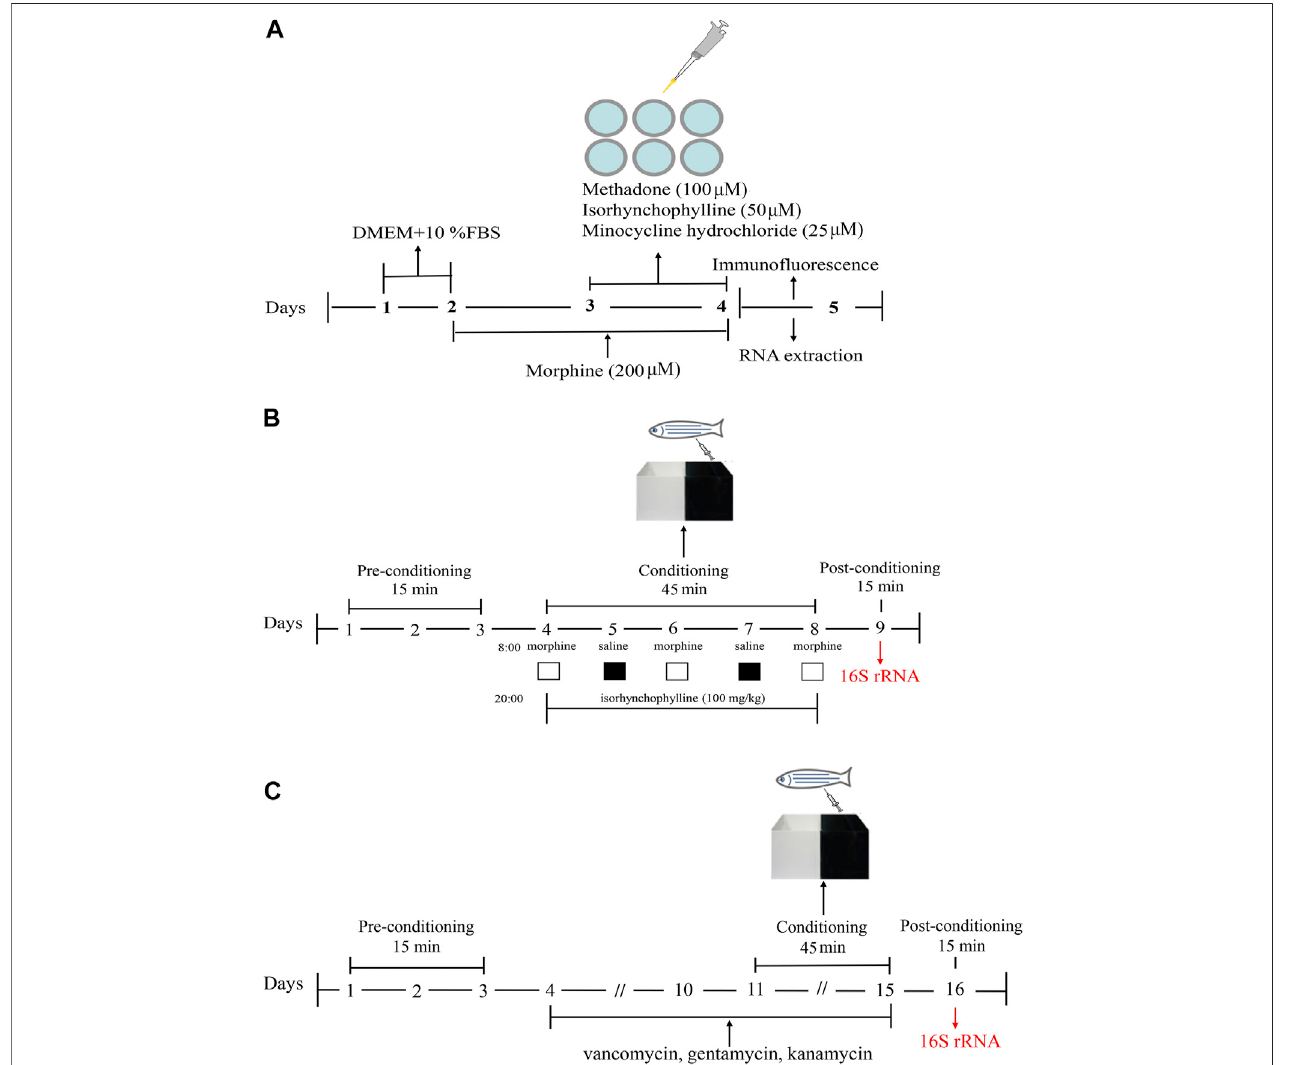
FIGURE1| Schematicoftheexperimentaldesign. (A) Schematicoftheexperimentaldesignforanalysisofmorphine-inducedactivationofBV2cells. (B) Schematic of the experimental design for the CPP test. (C) Schematic of the experimental design for antibiotic treatment combined with the CPP test.